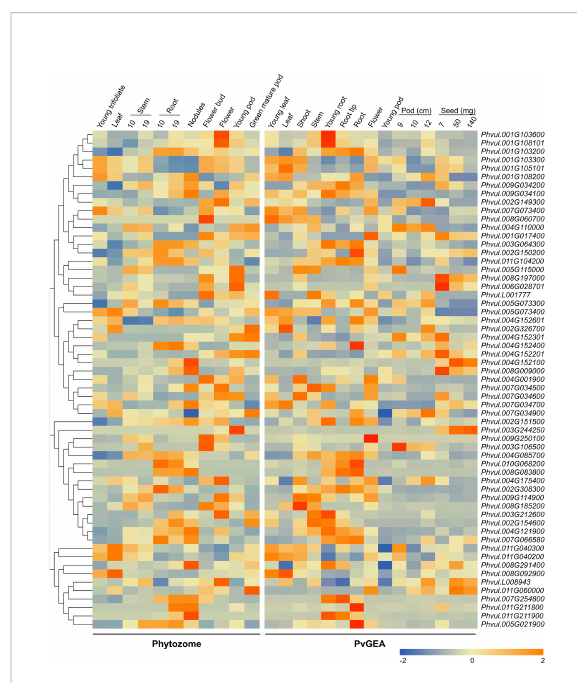
FIGURE 6 Heatmaps showing tissue-speci fi c expression of PvMATEs . Phytozome for landrace G19833 and PvGEA for cultivar Negro Jamapa were used for data sources. The color key represents the relative transcript abundance in a row analyzed in different tissues with the log 2 transformed values. Tissues with their developmental stages are labeled overhead. The gene cluster was imported from neighbor-joining-tree generated with PvMATE protein sequences in